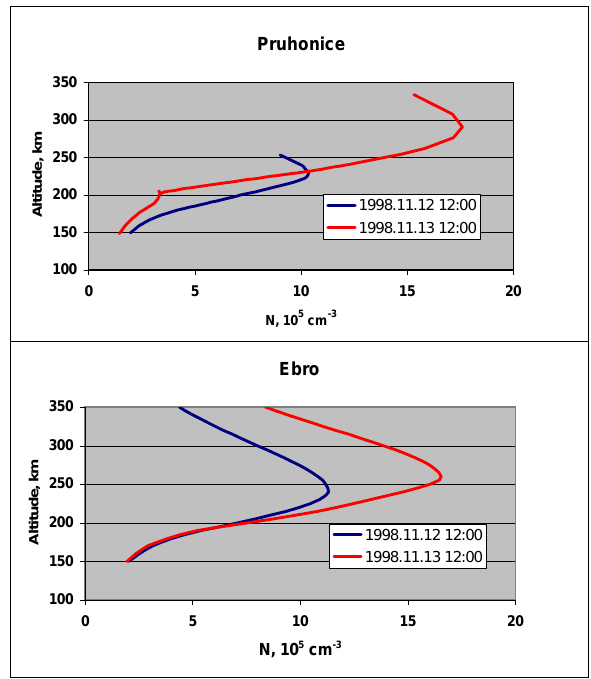
Fig. 3. The noontime electron density profiles in the F-region (150–350km) for the storm of November 1998, one day before the storm onset (blue line) and during the storm main phase (red line) for Pruhonice and Ebro. Altitude in km, electron density N in 10 5 cm − 3